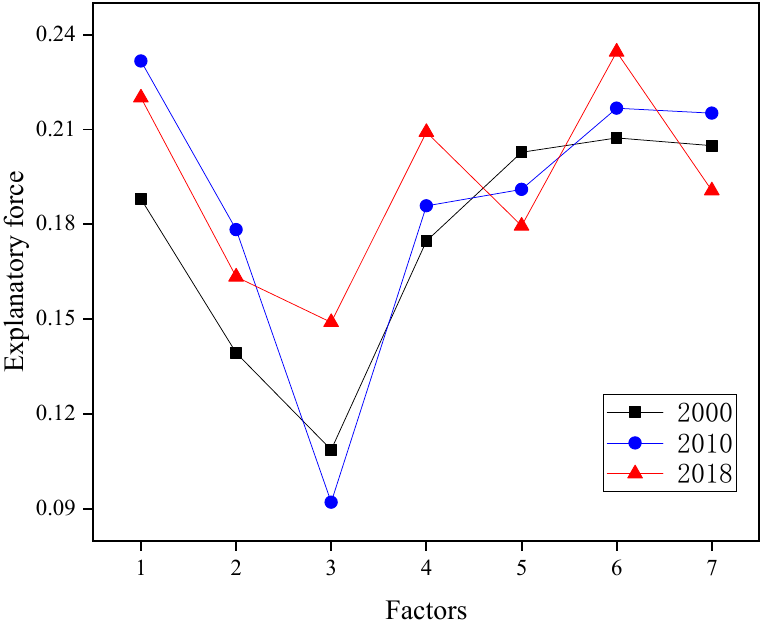
Figure 9. Map of landscape ecological risk influencing factors. Note: 1, 2, 3, 4, 5, 6, and 7 denote elevation, slope, precipitation, temperature, leaf area index, GDP, and population density, respec- tively.